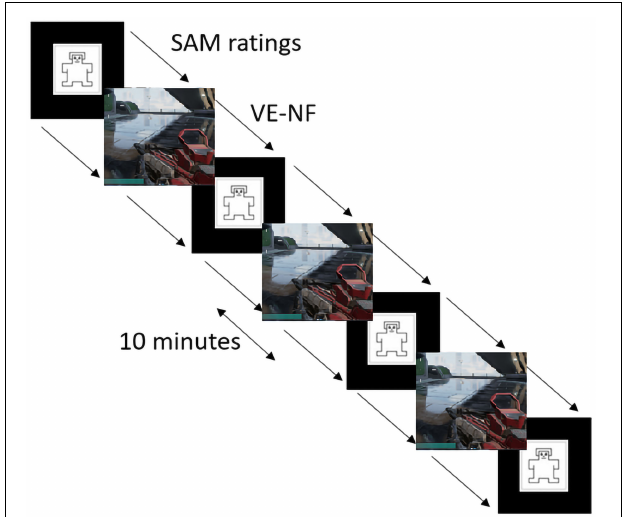
FIGURE 4 | Experimental design of the gaming sessions and SAM ratings (Bradley and Lang, 1994) within the scanner.